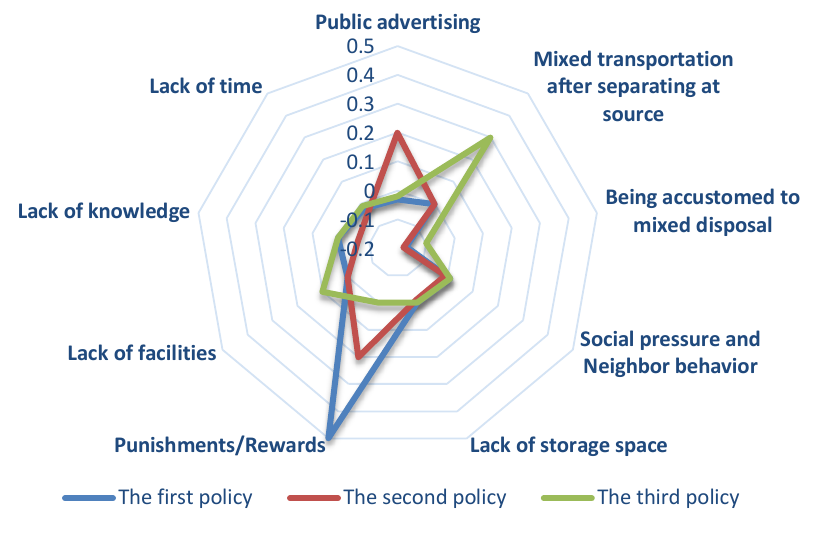
Figure 4 . Variables change percent in each policy After sensitivity analyzing in each of the policies, the percent change in the variables of the model was calculated as shown in Figure 5: